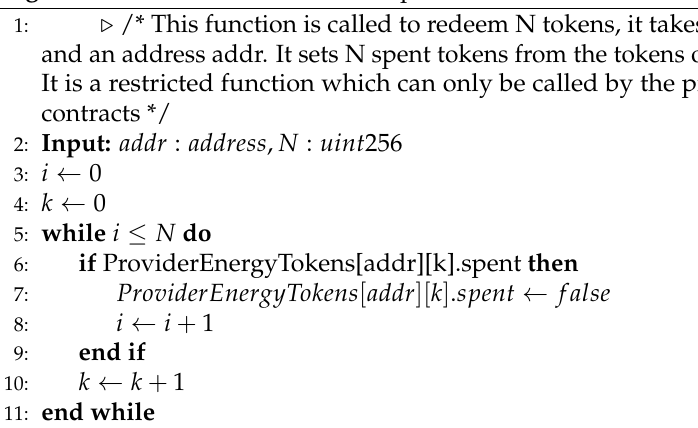
Algorithm 8 DSO Smart Contract: UpdateProviderBalance2